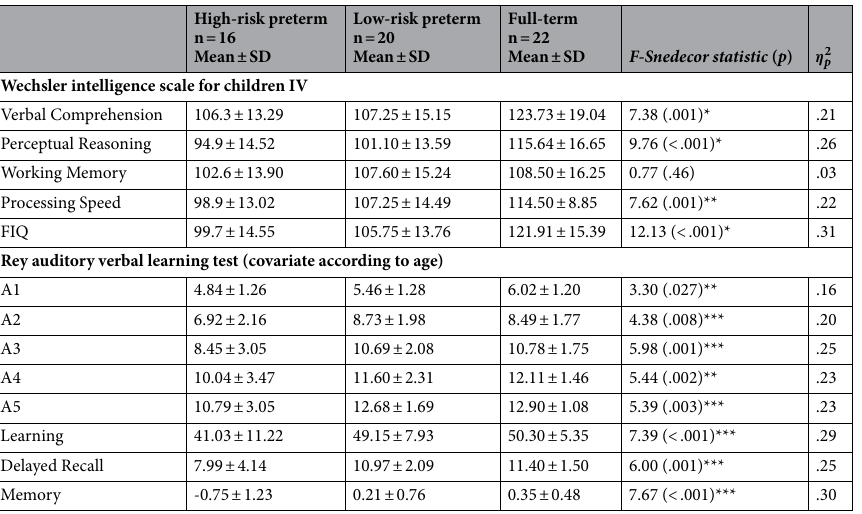
Table 3. Full intelligence quotient and learning-memory differences. SD: standard deviation; FIQ: full intelligence quotient; WISC-IV: Wechsler Intelligence Scale for Children IV; RAVLT: Rey Auditory Verbal 2 Learning Test; A1, A2, A3, A4 and A5: RAVLT trials; and η p : partial eta squared. *Statistically significant differences between High-risk preterm < Full-term and Low-risk preterm < Full-term. **Statistically significant differences between High-risk preterm < Full-term. ***Statistically significant differences between High-risk preterm < Full-term and High-risk preterm < Low-risk preterm.